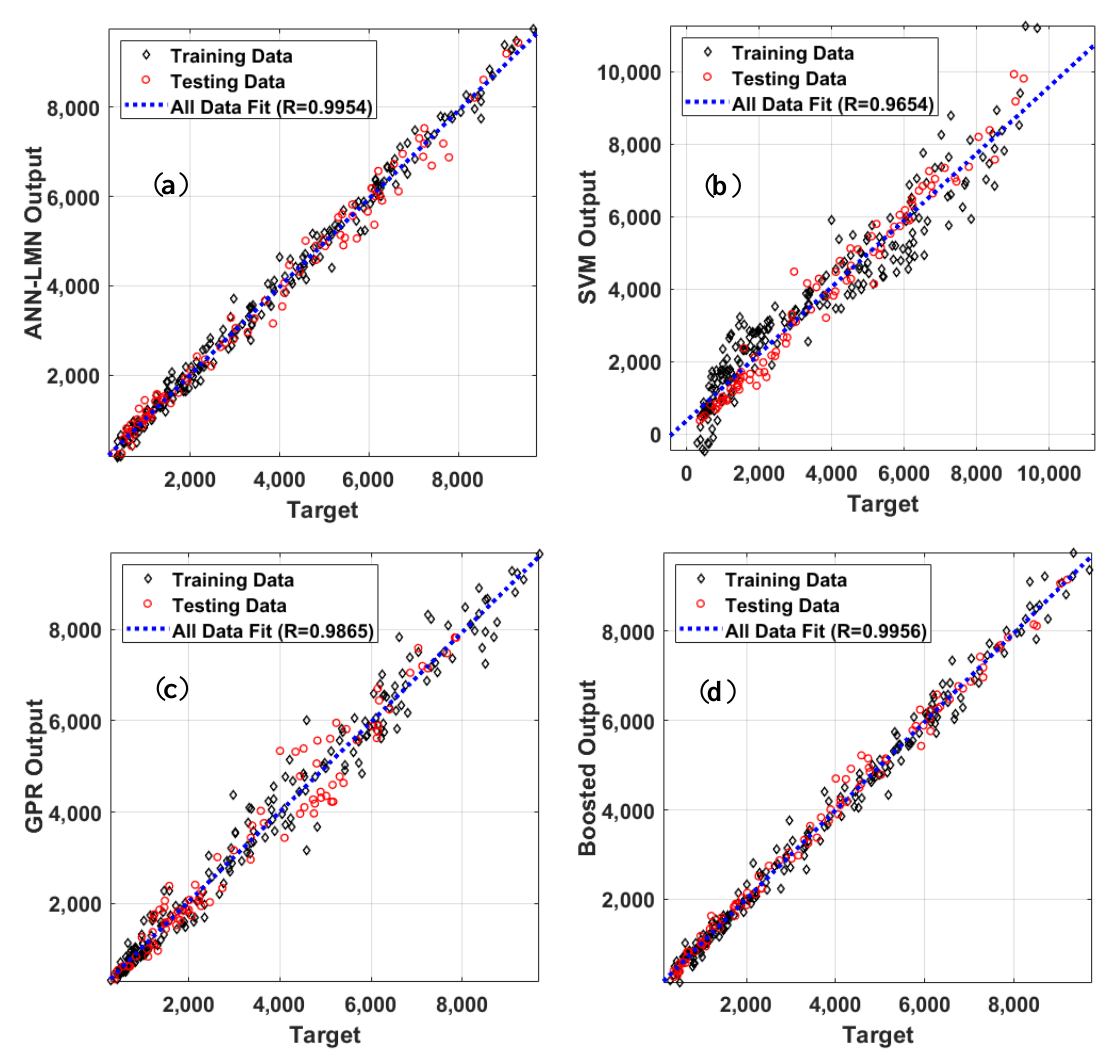
Figure 5. Graphs of correlation between measured E* versus predicted E* using ( a ) ANN-LMN, ( b ) Support vector mechanism (SVM), ( c ) Gaussian process regression (GPR), and ( d ) Boosted.